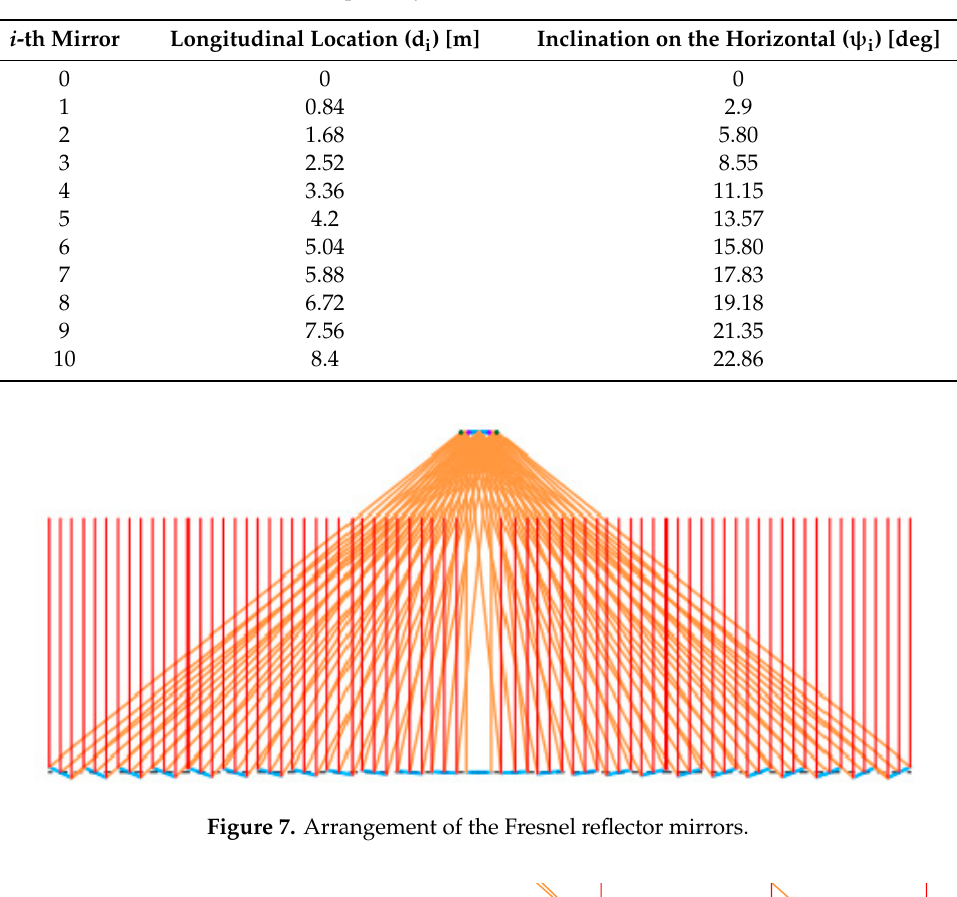
( b ) Figure 8. Results of the ray tracing. ( a ) Approach of the receiver. ( b ) Blocking of reflected rays between the last and second last mirror. 3. Results With the results of Table 3, the intercept factor for systems with variable height can be determined using the methodology described in the previous section, keeping fixed the layout and size of the primary mirrors. However, even the intercept factor is optimized as a function of height, the tilt of the mirrors must change in order to keep the absorber tube illuminated.